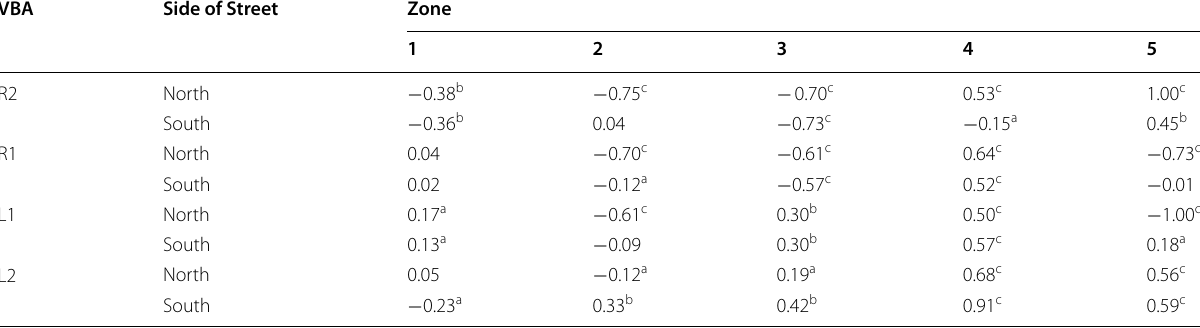
a Weak 0.1-0.3, b Moderate 0.3-0.5, c Strong Coefficient =